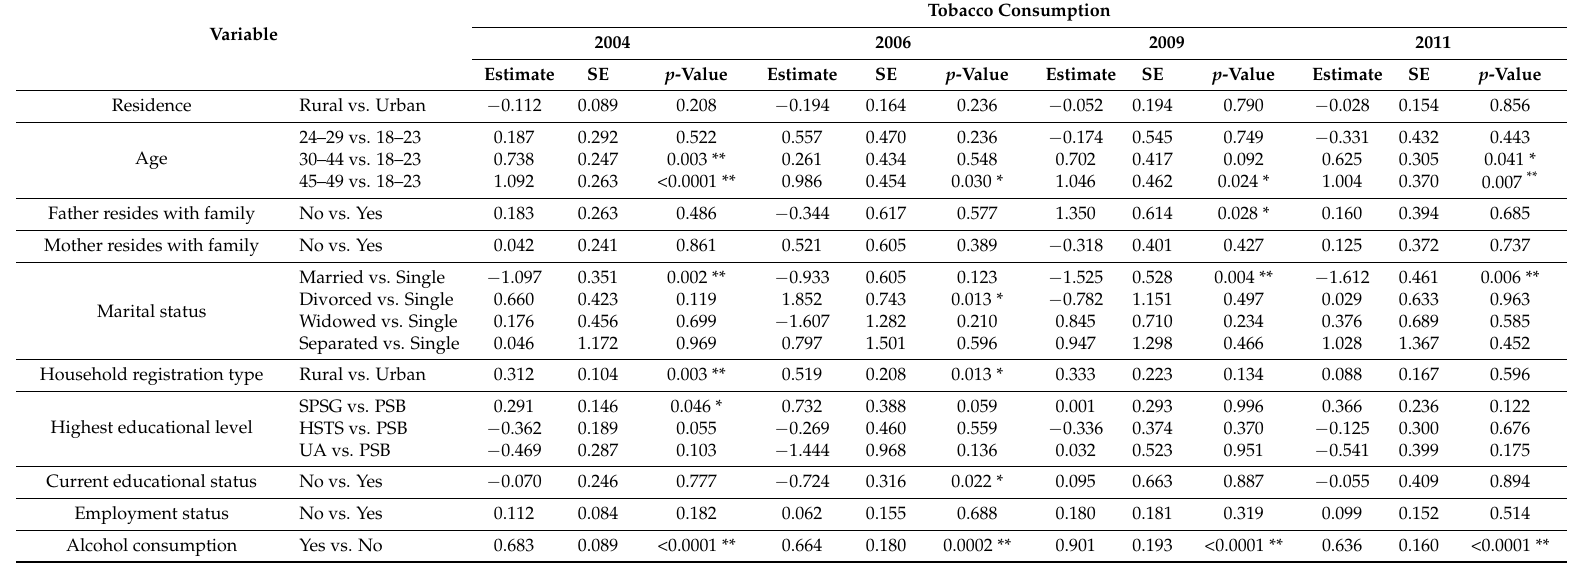
Table 5. Penalized logistic regression analysis of tobacco consumption among adult women of reproductive age (discontinuous